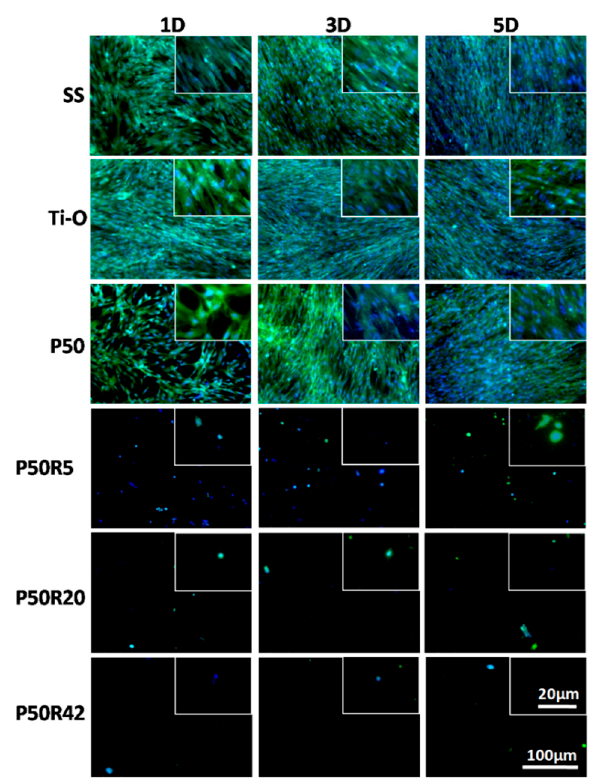
Figure 7. Immunofluorescence staining micrographs of smooth muscle cells (SMCs) actin and DAPI after culture on the SS, Ti–O, P50, P50R5, P50R20, P50R42 sample surfaces for 1, 3, and 5 days.